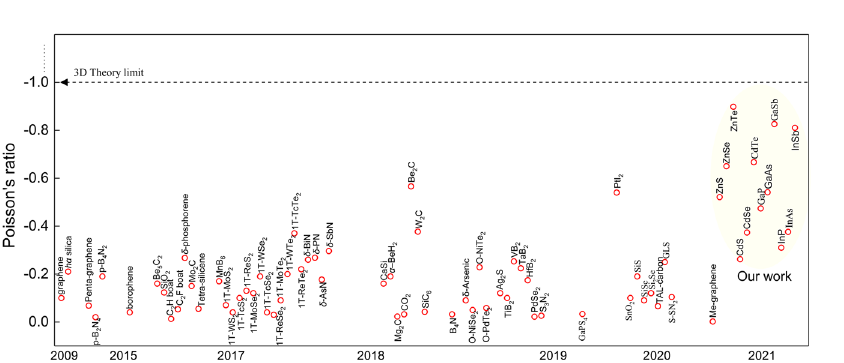
Fig. 4 Giant in-plane NPR for wz monolayers. Statistically 2D structure with NPR currently known, whose values are overall below the wz monolayers reported